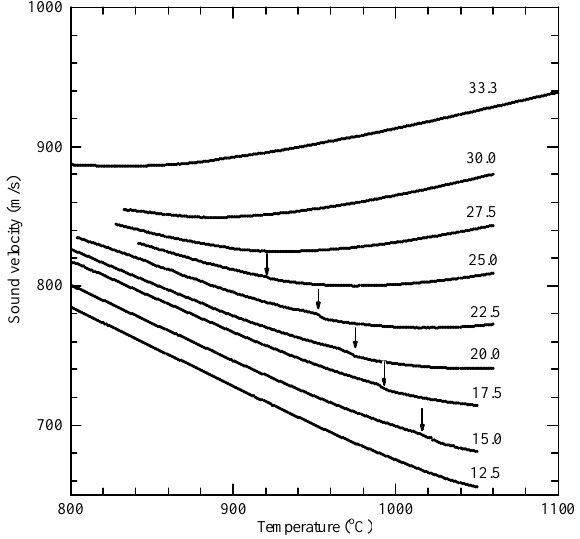
Fig. 2. Close-up of fig.1. Sound velocity in the liquid Ge-Se alloys with Ge concentration from 12.5 to 33.3 at.% (GeSe 2 ). An arrow indicates the position of step-wise change, T x . Numbers are at.% of Ge.